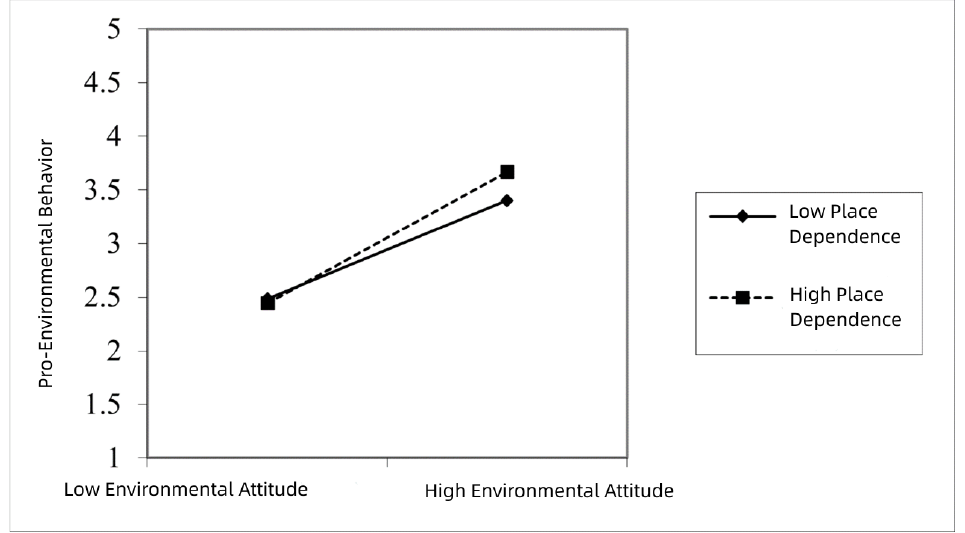
Figure 4. Moderating effect of place dependence.